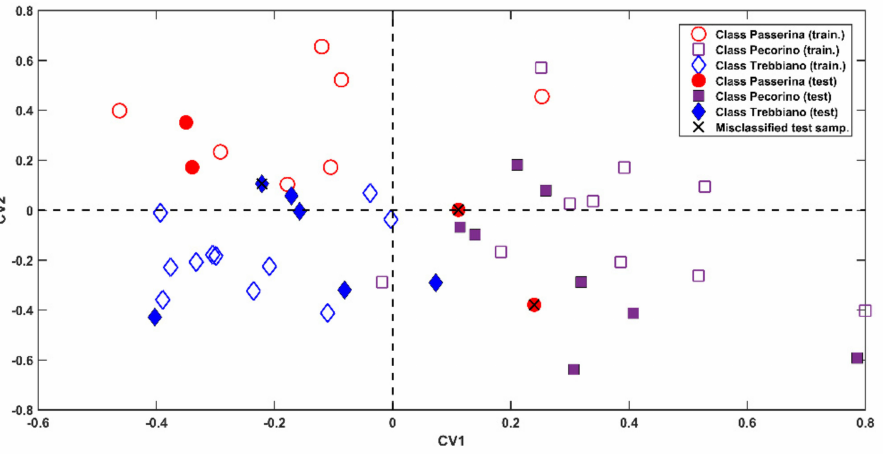
Figure 5. SO-PLS-LDA analysis. Wine samples projected onto the space of the two canonical variates (CV1 and